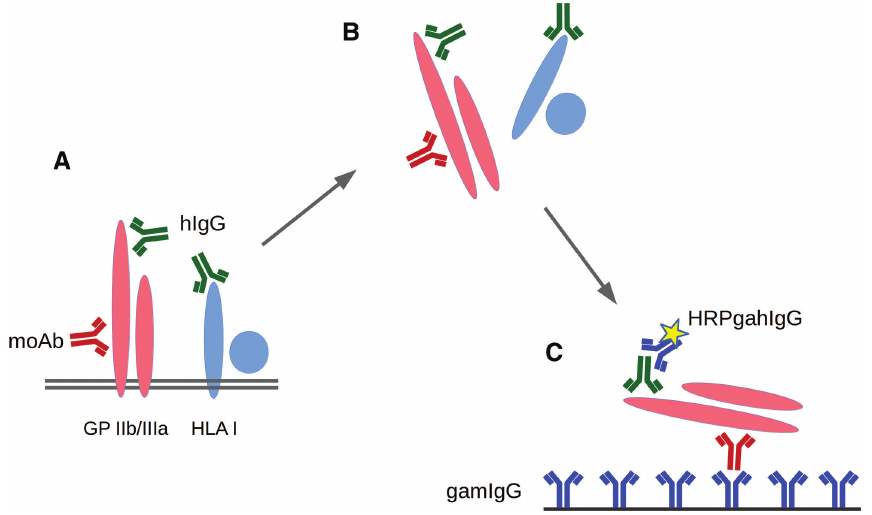
Figure 1: Principle of the MAIPA assay. Panel A shows a small section of the cell membrane of an intact platelet. Platelets are first incubated with the serum to be tested, apparently (human) antibodies (hIgG) react with GP IIb/IIIa and HLA class I molecules. In this experiment, antibodies against GP IIb/IIIa are of interest: after washing the platelets, they are incubated with a mouse monoclonal antibody against GP IIb/IIIa, which should react with an epitope different from the binding site recognized by the human antibody. After a further washing step, platelets are solubilized with a nonionic detergent (B), the lysate is then centrifuged in order to remove particulate material and the supernatants of the lysate are transferred to a microtiter platelet coated with goat anti-mouse IgG (C). The moAb-labeled GP IIb/IIIa will be fixed to the microtiter plate, whereas the unbound HLA I molecule will get lost during the next washing step. The (human) anti-GP IIb/IIIa will be detected with conventional ELISA technology with an enzyme-labeled goat anti-human IgG